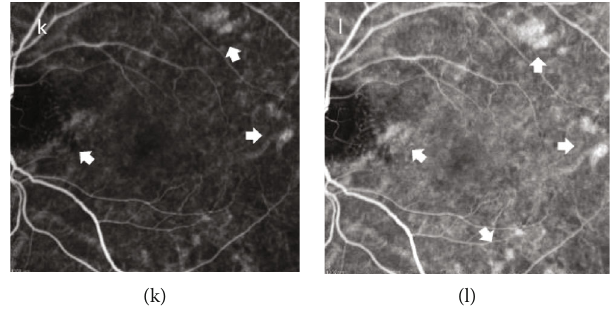
Figure 3: OCT images of RE (a) and LE (b) with CME in the papillomacular area of both eyes and SRF in the LE. FA pictures of RE (c and d) and LE (e and f) showing several small window defects causing hyper fl uorescence. Ten days later, the EDI-OCT performed (g and h) showed increased choroidal thickness and pachyvessels (asterisk, (h)) in both eyes ( LE > RE ) with additional SRF subfoveally in the RE (g); the IRF in the LE was slightly reduced, while SRF persisted (h). PFP was present temporally to the optic disc margin in the RE (white arrow, (g)). ICGA revealed pachyvessels (white arrows), especially superiorly to the ONH in the RE (i and j) and adjacent to the optic disc inferiorly in the LE (k and l), corresponding to hyper fl uorescent areas of choroidal hyperpermeability noted during the